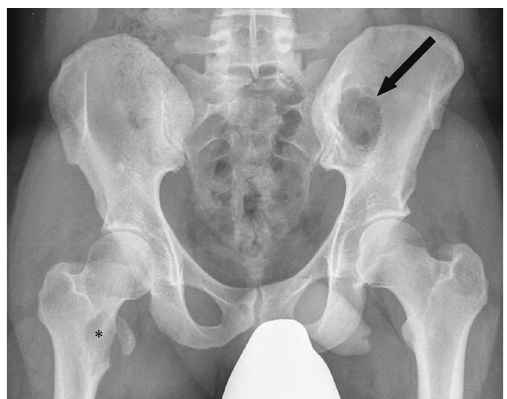
Figure 2: Conventional radiography, AP view of the pelvis: lytic lesions of the right proximal femur (asterisk) and of the left ileum (arrow) became